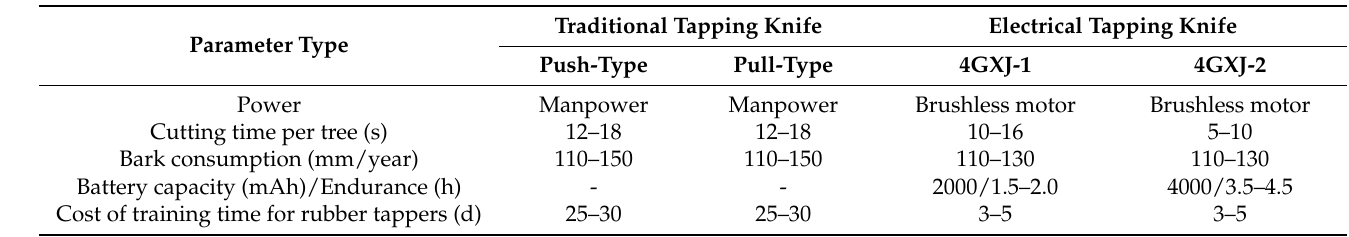
Table 3. Performance comparison between the traditional tapping knife and the electrical tapping knife